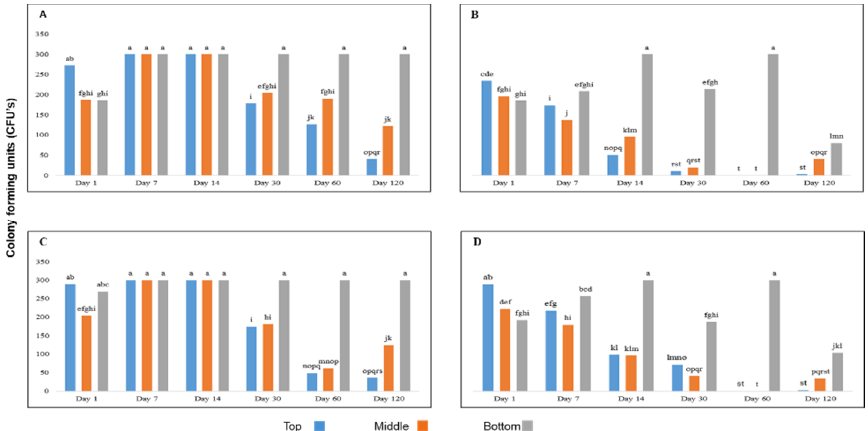
Figure 1. The effect of sampling depth, motion and the presence and absence of soil on the survival of Fusarium oxysporum f. sp. cubense in water. ( A ) Agitated water in the absence of soil, ( B ) Still water in the absence of soil, ( C ) Agitated water in the presence of soil and ( D ) Still water in the presence of soil. Significant differences ( p ≤ 0.05) according to Tukey’s test are indicated by different letters.